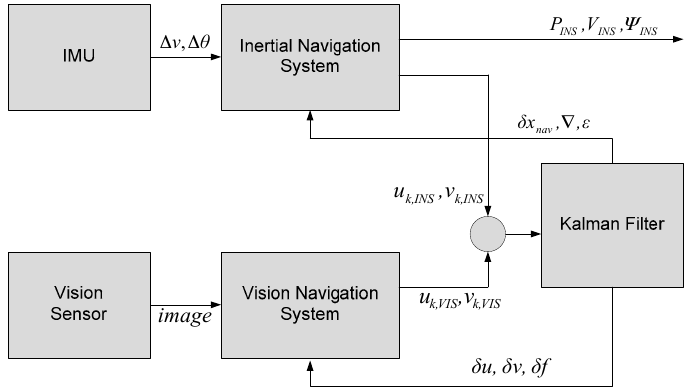
Figure 2. Proposed method of the vision/INS integrated navigation system.